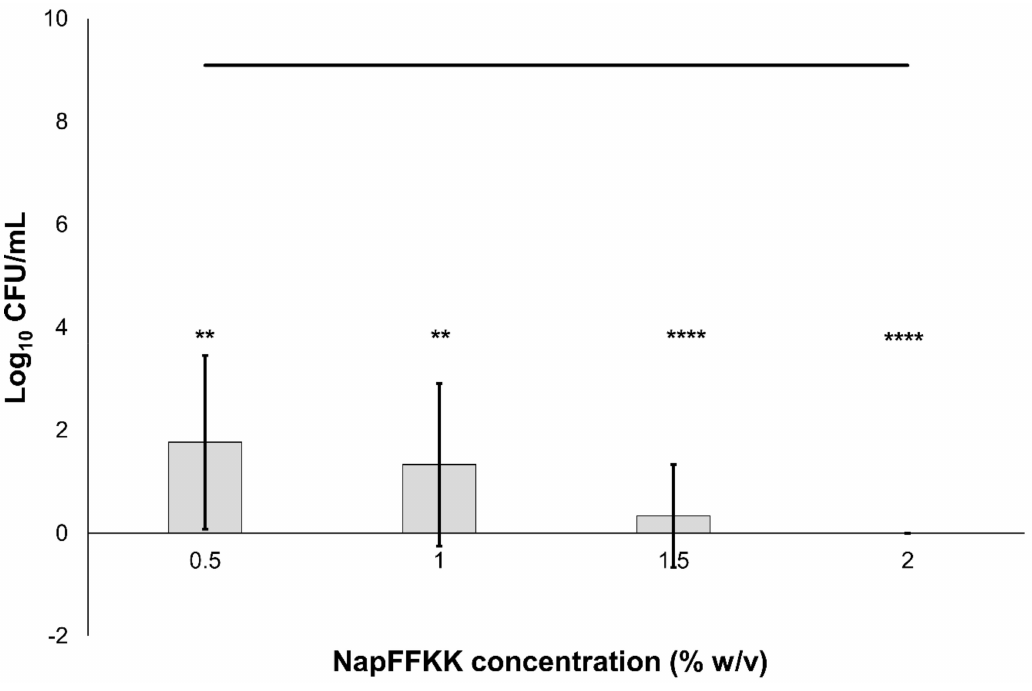
Figure 7. Fungal viability counts (Log 10 CFU/mL) of Candida glabrata ATCC 2001 after 24 h exposure to NapFFKK-OH. Black line represents negative growth control (fungi only). **: p < 0.01, ****: p < 0.0001 significant difference between Log 10 CFU/mL NapFFKK-OH treatment and the negative